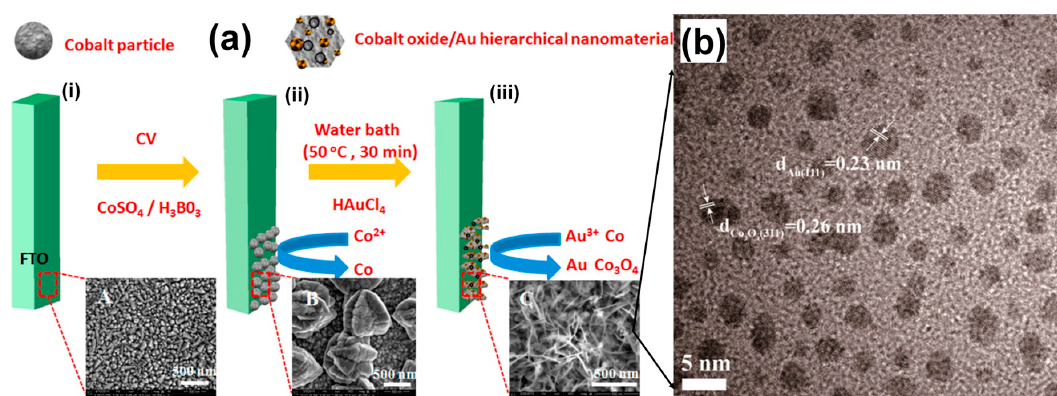
Figure 6. ( a ) Scheme for fabrication of cobalt oxide/Au hierarchically nanostructured electrode: (i) FTO; (ii) cobalt particles and (iii) Co 3 O 4 /Au hierarchically nanostructured material; ( b ) TEM images of Co 3 O 4 /Au hierarchically nanostructured material. Reprinted and adapted with permission from Reference [93]. Copyright American Chemical Society, 2016.